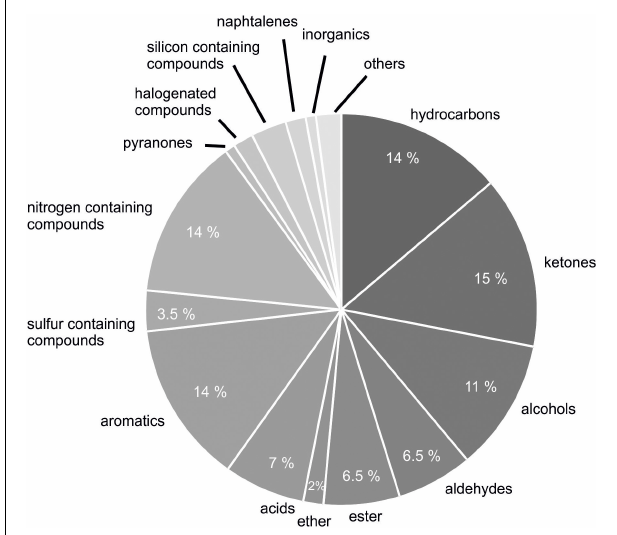
FIGURE 2 | Classification of detected VOCs according to chemical classes. Two hundred and thirty-one volatile secondary metabolites emitted from 26 B. subtilis isolates were summarized from 20 original scientific publication (see Table 1 ) and grouped in chemical